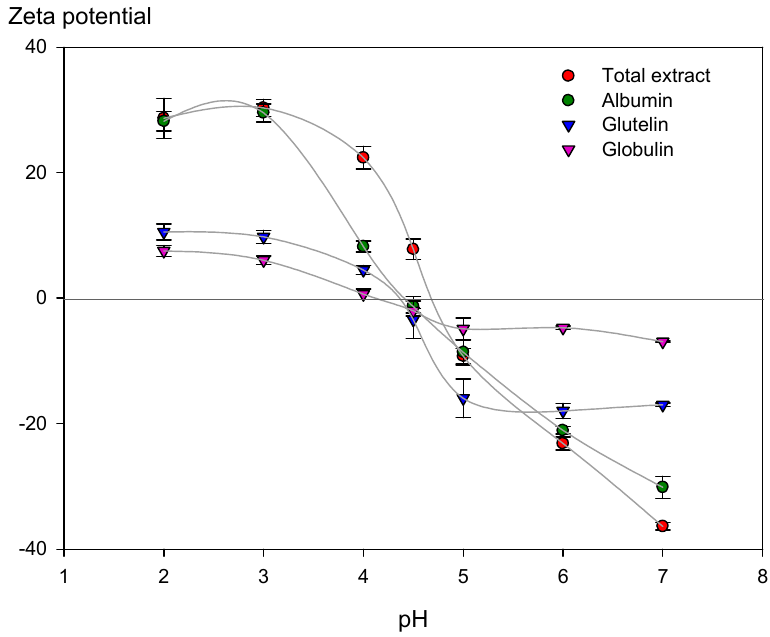
Figure 4. Zeta potential of proteins extracted from chickpea flour. Protein concentration 0.1% ( w/v ).